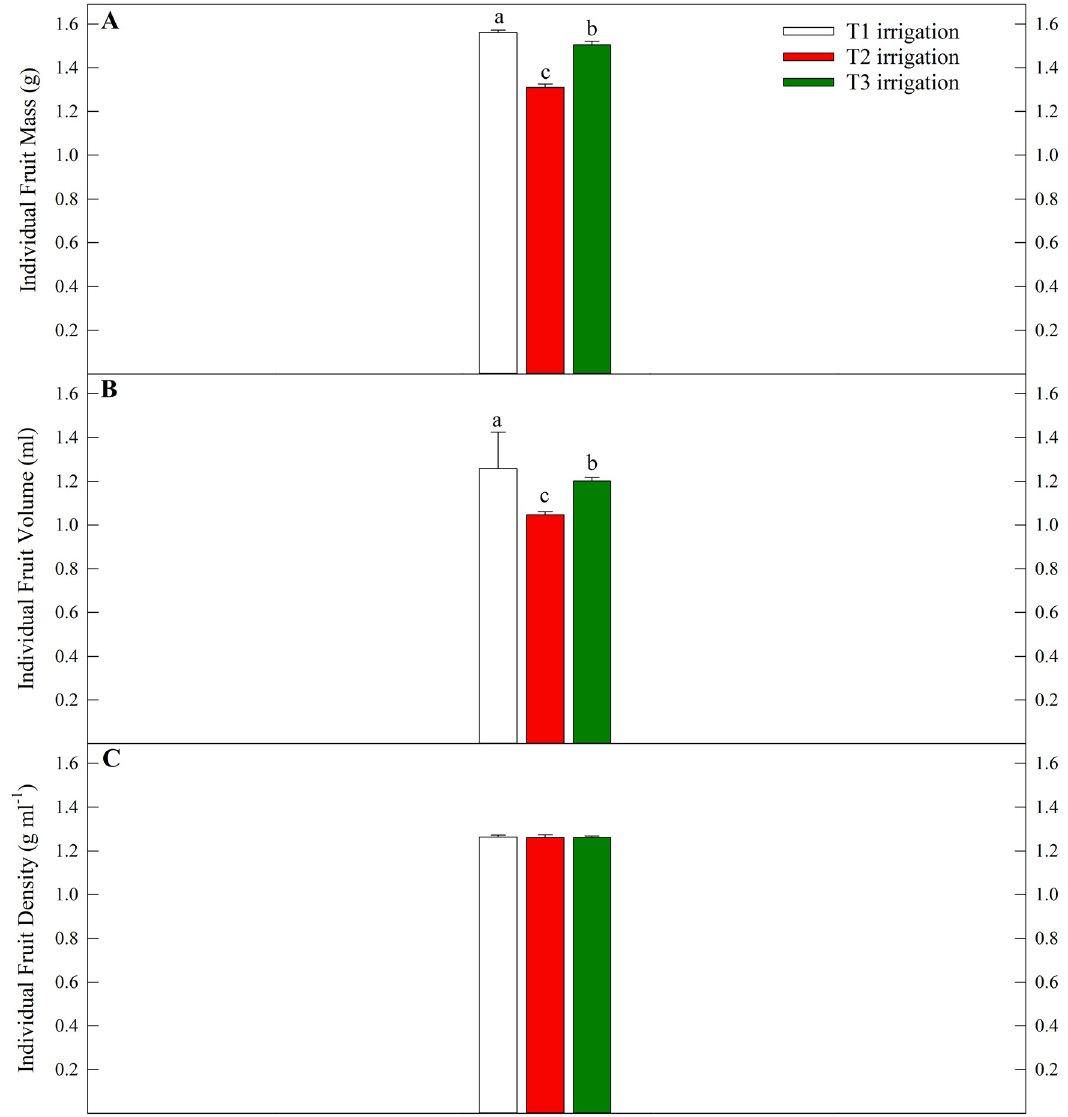
Figure 5: E ff ect of three irrigation regimes on individual fruit mass ( a ) , individual fruit volume ( b ) , and individual fruit density ( c ) for olive trees ( Olea europaea L. cv. “ Arbequina ” ) growing in Orchard 3 ( located near Artesia Wells, TX ) . Letters above each bar represent di ff erences between T1 ( single irrigation emitter ) , T2 ( two irrigation emitters ) , and T3 ( control, three irrigation emitters ) irrigation treatments ( Tukey – Kramer test, P ≤ 0.05 ) . Error bars represent SE for each irrigation